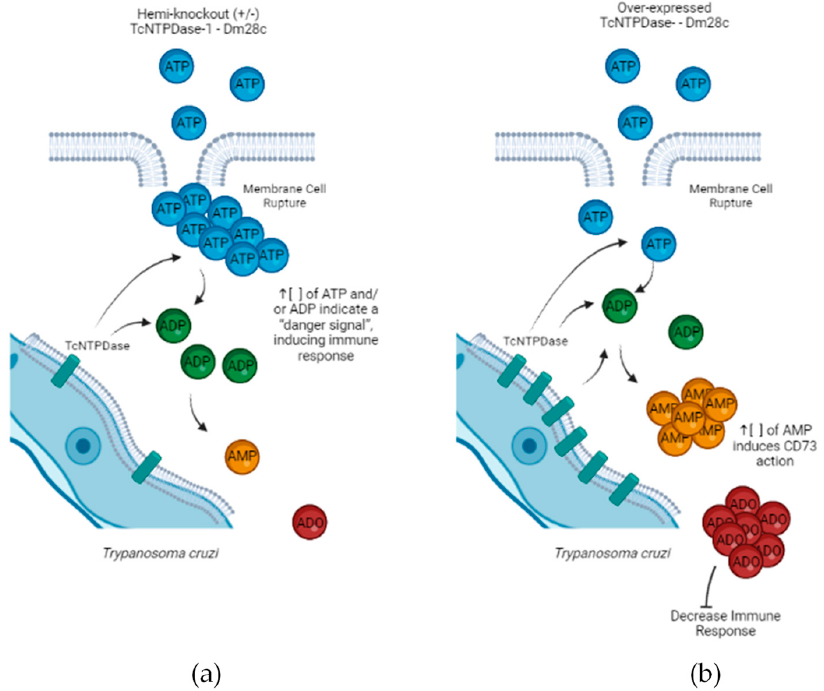
Figure 6. Schematic drawing of the possible action of TcNTPDase-1 during infection by recombinant Trypanosoma cruzi . In the scheme, the extracellular trypomastigote form is partially represented. ( a ) T. cruzi hemi-knockout (KO +/ − ) showing lower expression of TcNTPDase-1, converts a lower number of ATP molecules that signals for immune system activation. ( b ) T. cruzi overexpressing TcNTPDase-1 has great ability to convert ATP/ADP to AMP. Increased concentration of extracellular AMP induces ecto-5 ′ -nucleotidase (CD73) to convert AMP to adenosine (ADO), which binds to P1 receptors decreasing the immune response.